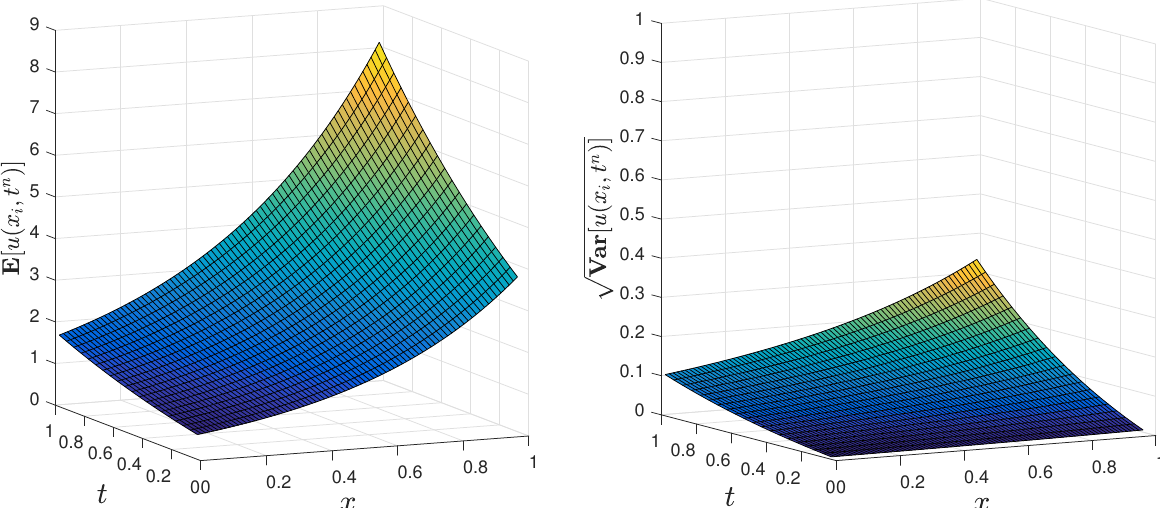
Figure 1. ( Left ): Surface of the expectation of the exact solution (50), E [ u ( x i , t n )] , computed according to (51). ( Right ): (cid:112) Surface of the standard deviation of the exact solution (50), Var [ u ( x i , t n )] , computed according to (52) and (53). For both statistical moments the parameters considered in (50) are a ∼ N [ 0.4,0.6 ] ( 0.5;0.1 ) , c ∼ Beta [ 0.45,0.55 ] ( 2;4 ) and the plotted domain corresponds to ( x i = ih , t n = nk ) ∈ [ 0 + h = 0.0125,1 − h = 0.9875 ] × [ 0.05,1 ] with the step-sizes h = ∆ x = 0.0125, 1 ≤ i ≤ 79, and k = ∆ t = 0.05, 1 ≤ n ≤